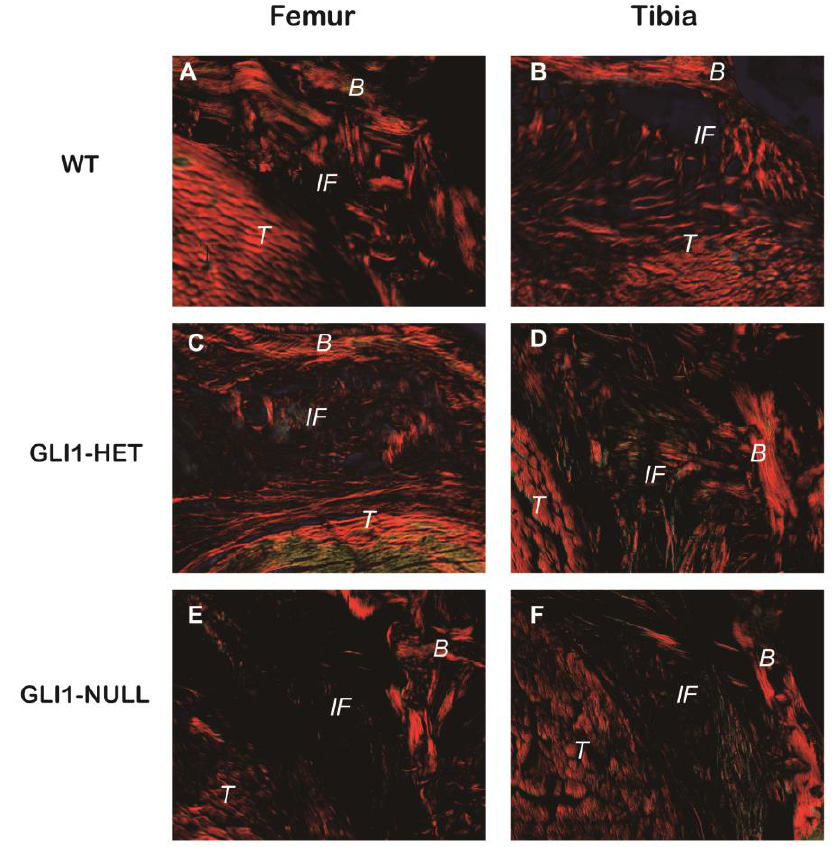
Figure 5. Picrosirius red staining of the tendon – bone interface of Wild-Type ( A , B ), GLI1-HET ( C , D ), and GLI1-NULL ( E , F ) mice at 4 weeks after ACLR (40×). Oblique or perpendicular collagen fibers that crossed the tendon – bone interface were formed in the WT group and GLI1-HET group, while there were minimal, poorly organized connecting collagen fibers at the interface in the GLI1-NULL group. (B: Bone tissue, IF: Interface, T: Tendon graft).